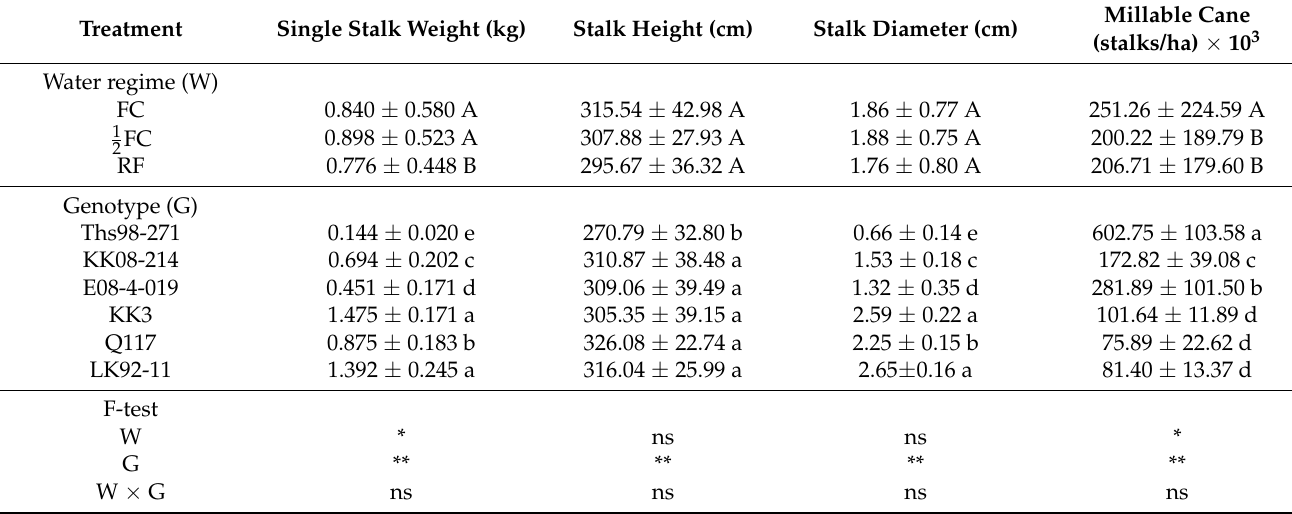
Table 10. Single stalk weight, stalk height, stalk diameter and millable cane of six sugarcane genotypes grown under FC and RF) conditions. well-watered (FC) and water-stressed ( 1 2